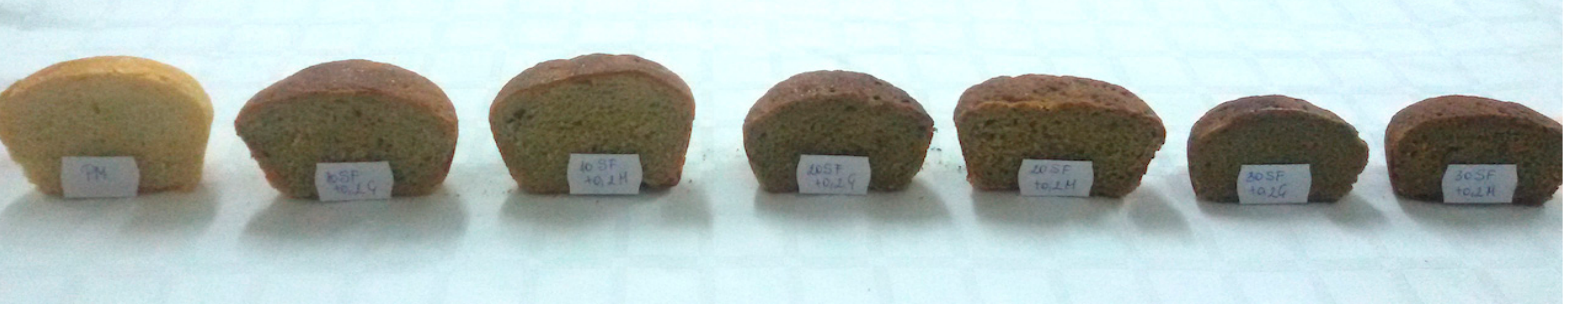
Figure 2. Buns with addition of sprouted buckwheat flour and 0.2% guar gum, 0.2% baking improver, respectively and sections of the obtained final baked buns. PM: control sample; 10SF1: buns with 10%, sprouted buckwheat flour and 0.2% guar gum; 20SF1: buns with 20%, sprouted buckwheat flour and 0.2% guar gum; 30SF1: buns with 30%, sprouted buckwheat flour and 0.2% guar gum; 10SF2: buns with 10%, sprouted buckwheat flour and 0.2% Magimix; 20SF2: buns with 20%, sprouted buckwheat flour and 0.2% Magimix; 30SF2: buns with 30%, sprouted buckwheat flour and 0.2% Magimix.